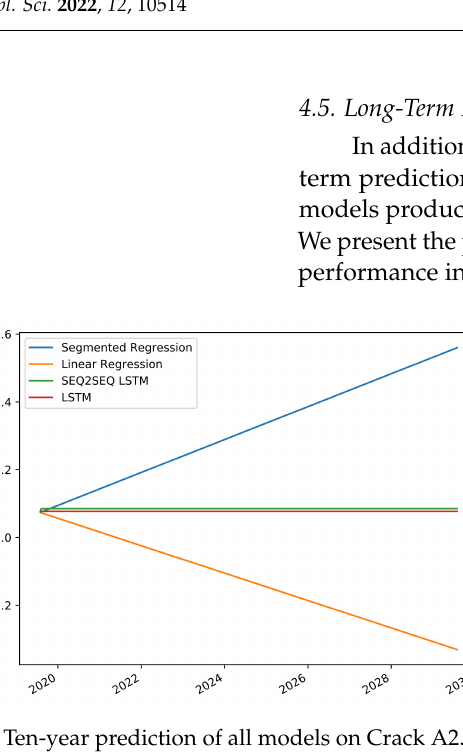
Figure 8. Long-term prediction of all models on Crack A2. ( a ) Ten-year prediction of each model on Crack A2 from 1 August 2019 to 1 August 2029, and ( b ) displays eight-month prediction of each model on Crack A2 from 1 August 2019 to 1 April 2020.